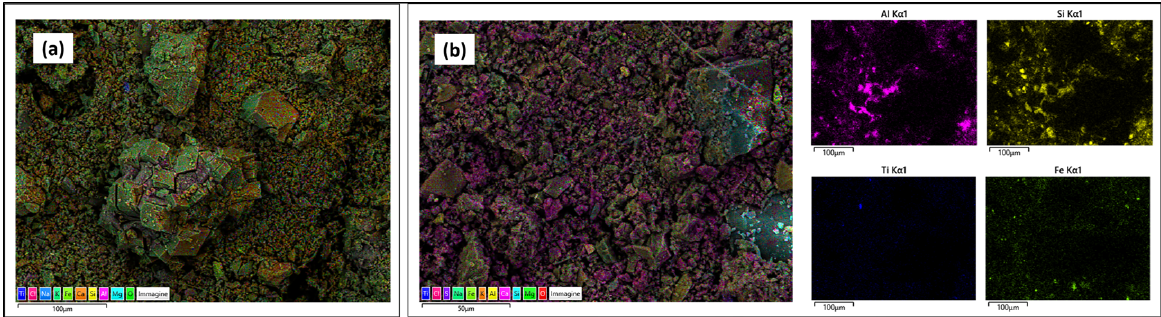
Figure 14. ( a ) P4 SEM image, mix of secondary and backscattered detection; ( b ) Elemental EDX maps.